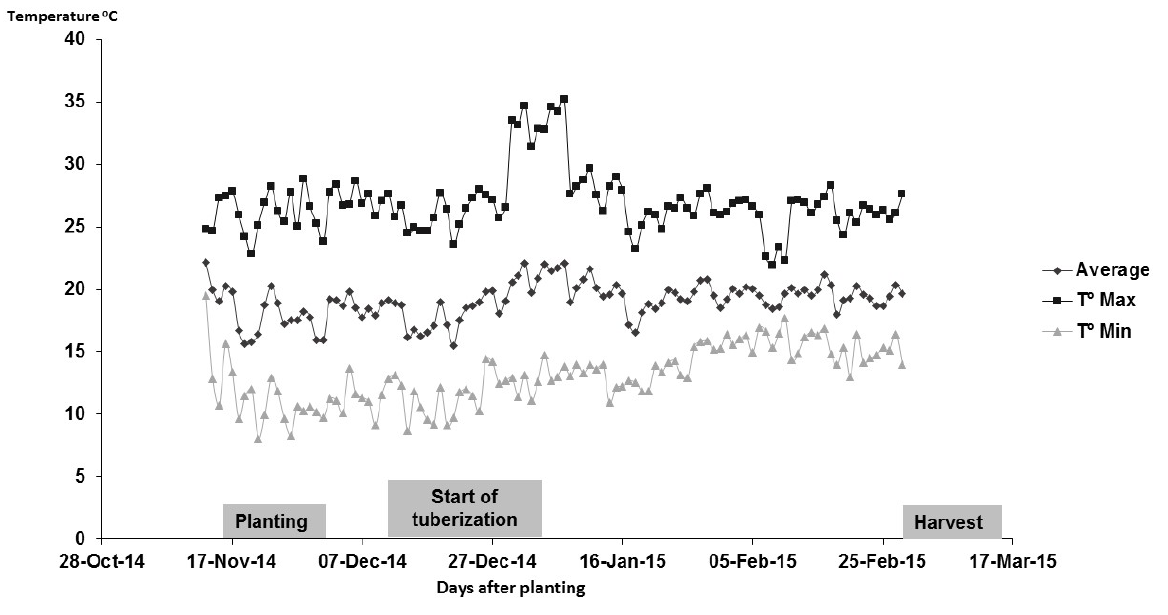
Figure 1: Temperatures during growing season in Majes, Peru, November 2014 to February 2015